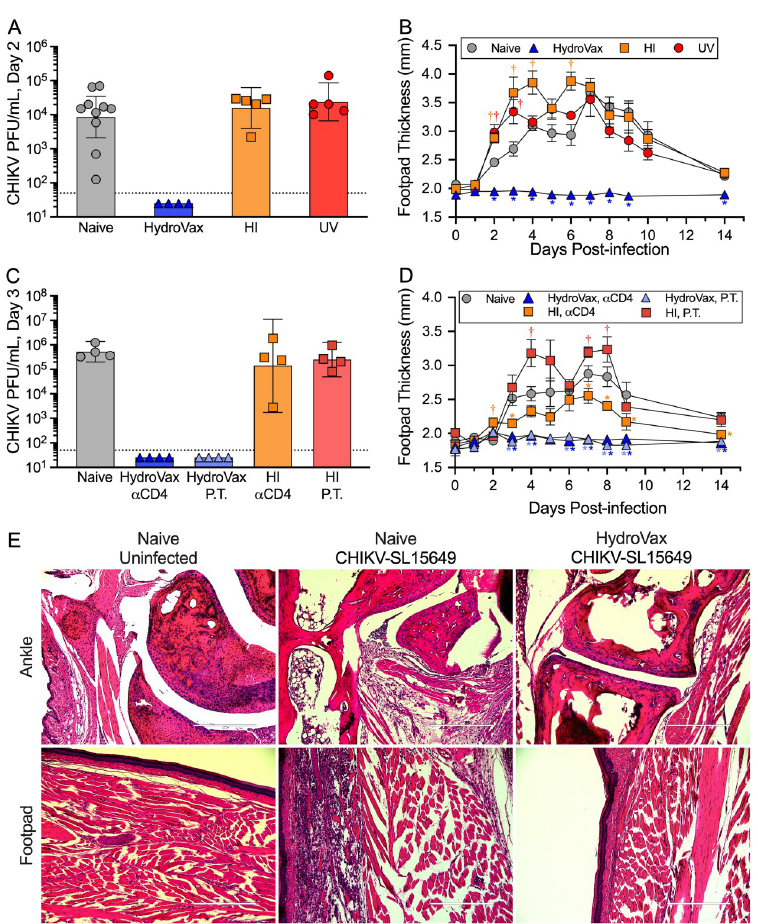
Fig 4. HydroVax-CHIKV vaccination protects against viremia and virus-associated arthritic disease following heterologous CHIKV challenge. Purified CHIKV-181/25 was inactivated with the optimized HydroVax approach (20 hours at room temperature), heat inactivation (HI-CHIKV, 1 hour at 80˚C) or ultraviolet irradiation (UV, 10J). C57BL/6 mice ( n = 4–10 mice per group) were immunized on days 0 and 28 with either a low dose of the optimized HydroVax-CHIKV (2 μ g) or a high dose (5 μ g) for HI-CHIKV and UV-CHIKV. At 3–4 months after primary immunization, mice were challenged in the footpad with 1,000 PFU of CHIKV-SL15649, along with age-matched na ï ve mice. (A) CHIKV viremia was assessed at 2 days post-challenge and (B) footpad swelling was monitored for up to two weeks. (C) Additional mice ( n = 4 per group) were vaccinated with HydroVax-CHIKV or heat-damaged HI-CHIKV at 2 μ g/dose on days 0 and 28 and challenged with CHIKV-SL15649 at 4 months post-primary vaccination. Animals from each group were depleted of CD4 + T cells or they received 300 μ L of convalescent serum from HydroVax- or heat-inactivated vaccine-immunized animals at 1 day prior to challenge as indicated (passive transfer; P. T.) and viremia was measured by plaque assay on day 3 post-challenge. (D) Footpad swelling measurements were performed for 14 days after CHIKV-SL15649 challenge. For panels A and C, the dotted line indicates the limit of detection for viremia. Individual data points are shown along with the geometric mean represented by a bar and 95% confidence intervals. For panels B and D, group averages with ± SEM values are shown. Comparisons were made at each time point to na ï ve controls using ANOVA with multiple test correction. Significant differences ( P < 0.05) in footpad thickness relative to na ï ve mice are indicated, with a dagger symbol (†) signifying an increase in footpad swelling, while asterisks ( � ) denote a significant decrease in footpad swelling in comparison to na ï ve controls. (E) At 10 days post-infection, histopathology in the ankle joint ( upper panels ) and footpad ( lower panels ) was assessed among representative animals by hematoxylin and eosin staining; ( left ) na ï ve, uninfected mice; ( middle ) unvaccinated na ï ve mice after CHIKV infection; ( right ) HydroVax-CHIKV immune mice after CHIKV infection. White scale bars represent 400 μ m.